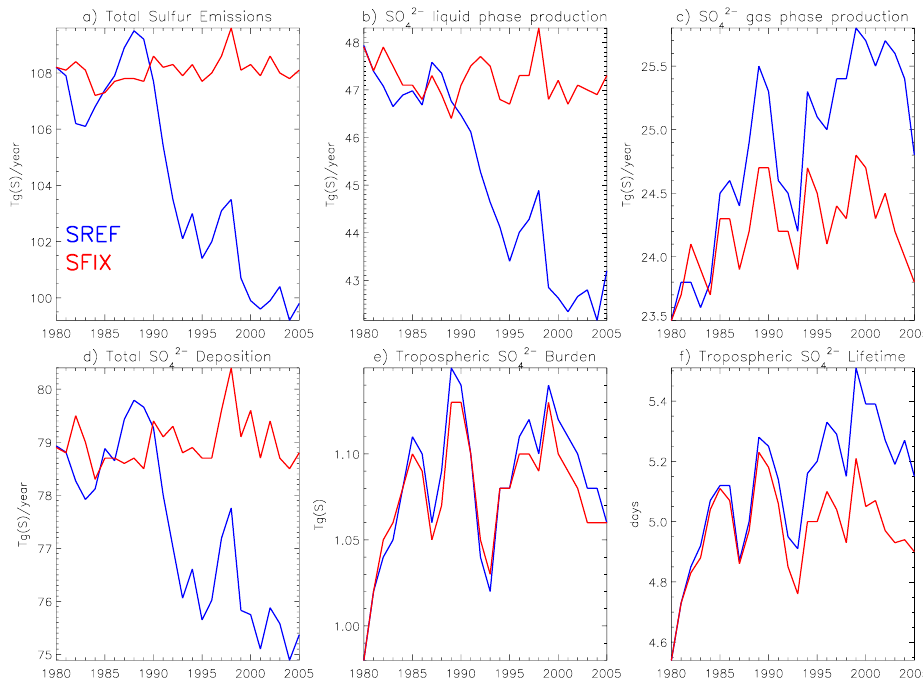
Fig. 13. Global tropospheric SO 2 − budget calculated for the period 1980–2005 for the SREF (blue) and SFIX (red) ECHAM5-HAMMOZ 4 simulations: (a) total sulfur emissions; (b) SO 2 − liquid phase production; (c) SO 2 − 4 SO 2 − burden; (f) lifetime. 4